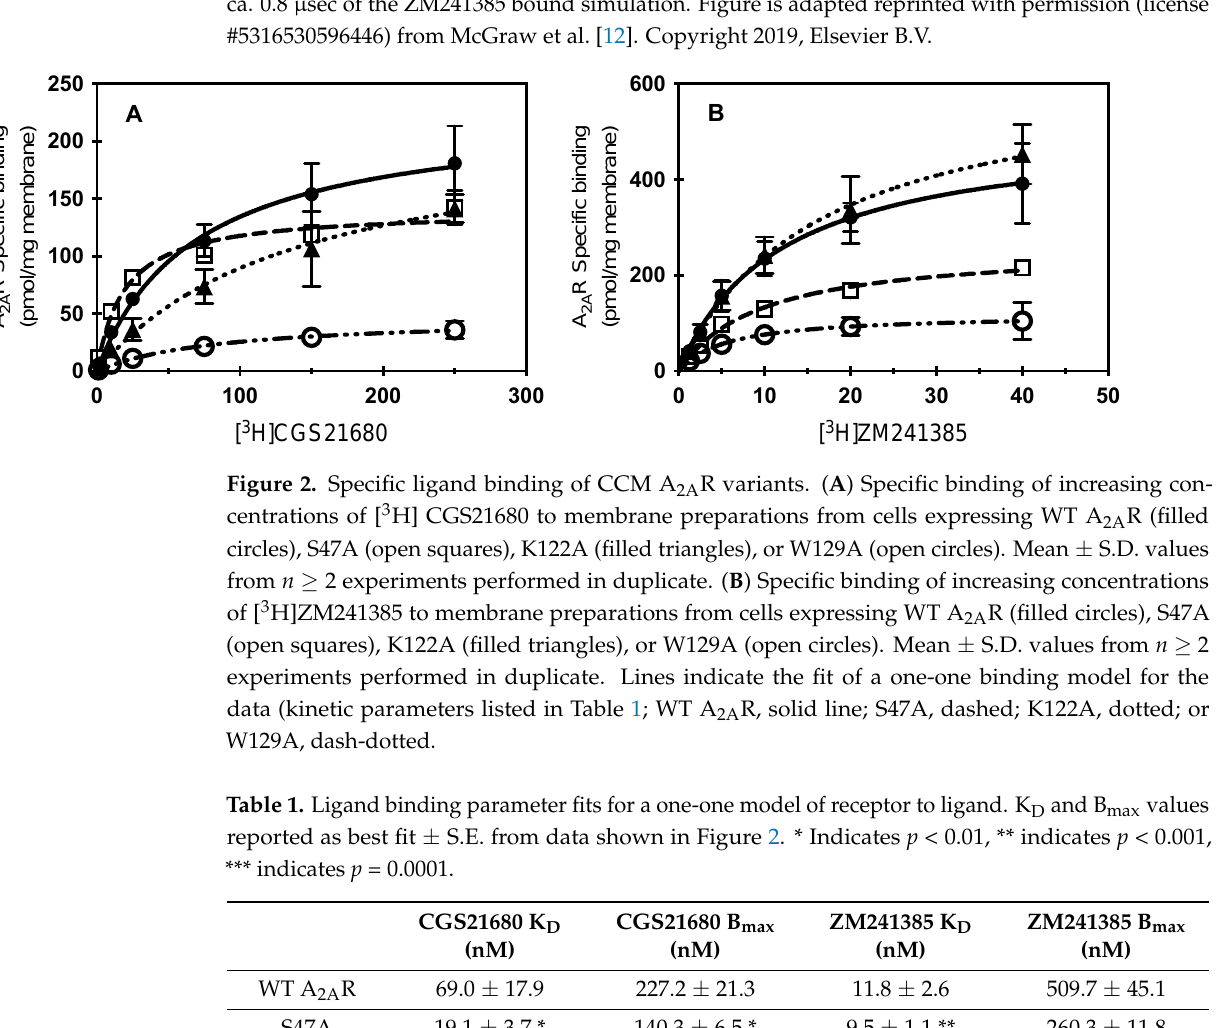
Figure 1. Cholesterol association to the A 2A R CCM. Cholesterol bound to the CCM during simula- tions. ( A ) A snapshot from the UK432097-bound simulation, showing the disposition of cholesterol (yellow, black spheres show the methyls of the beta face and red the hydroxyl) relative to the CCM (shown in space filling representation) in a tightly bound configuration. ( B ) The closest approach obtained between cholesterol and the CCM in any of the inactive receptor simulations (snapshot from ca. 0.8 µ sec of the ZM241385 bound simulation. Figure is adapted reprinted with permission (license #5316530596446) from McGraw et al. [12]. Copyright 2019, Elsevier B.V.